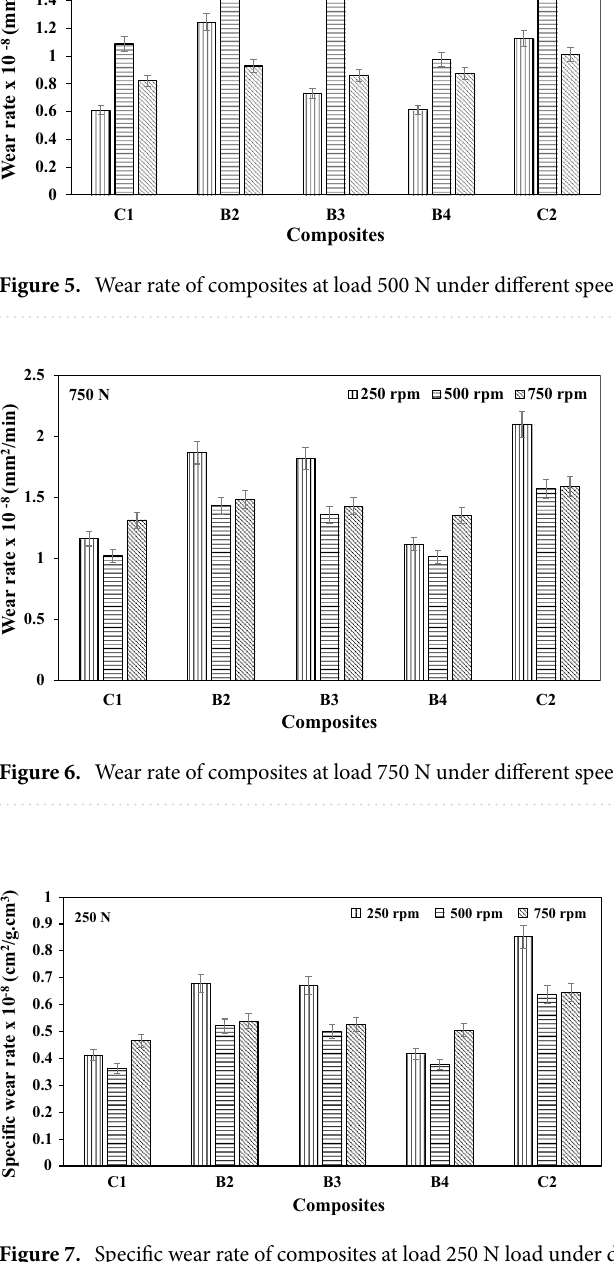
Figure 7. Specific wear rate of composites at load 250 N load under different